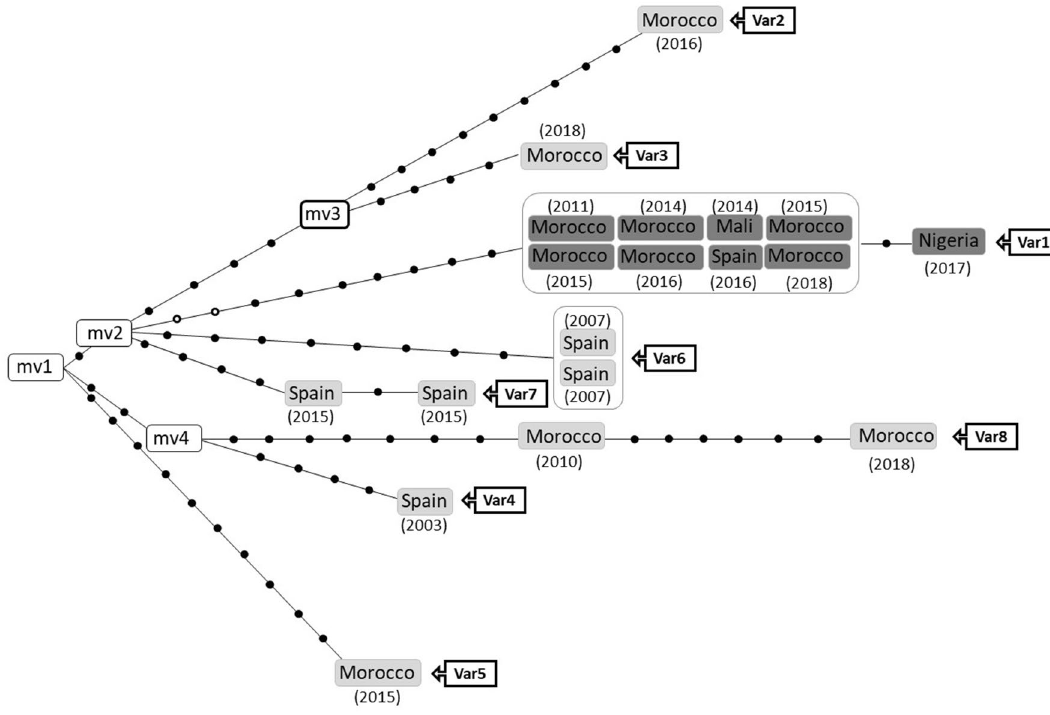
Figure 2. Each box represents a patient, differentiating the ones infected by the successfully transmitted variant (Variant 1, coloured in dark grey) from those infected by unsuccessfully transmitted closely related variants (in light grey). Patient´s origin is indicated within the box and the year of diagnosis in brackets. When two or more cases share identical sequences (0 SNPs between them) they are boxed, surrounded by a line. Each black dot represents a SNP. The white circles in Variant 1 branch correspond to non-fixed alleles, found in heterozygosis in the index case (Morocco-2011) but in homozygosis in the remaining cases. In the white boxes the name of the variant is indicated (Var). mv median vectors (corresponding to not-sampled